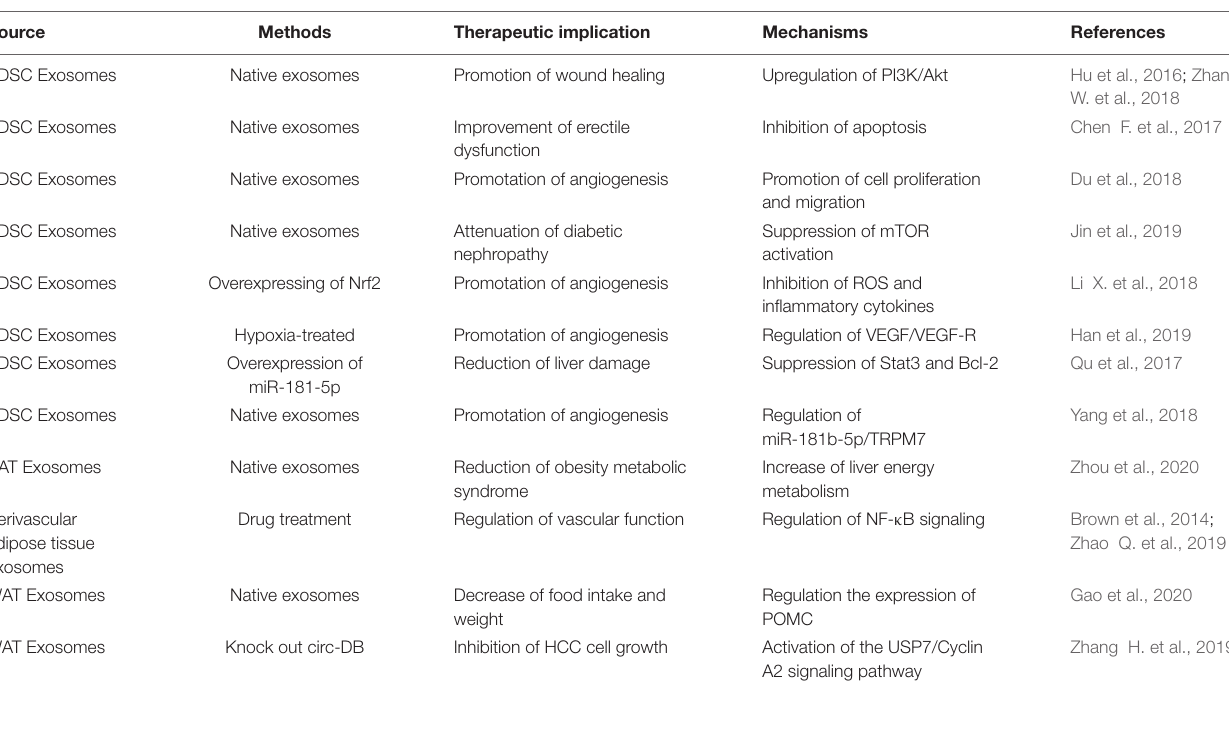
TABLE 2 | Therapeutic effects of adipose tissue-derived